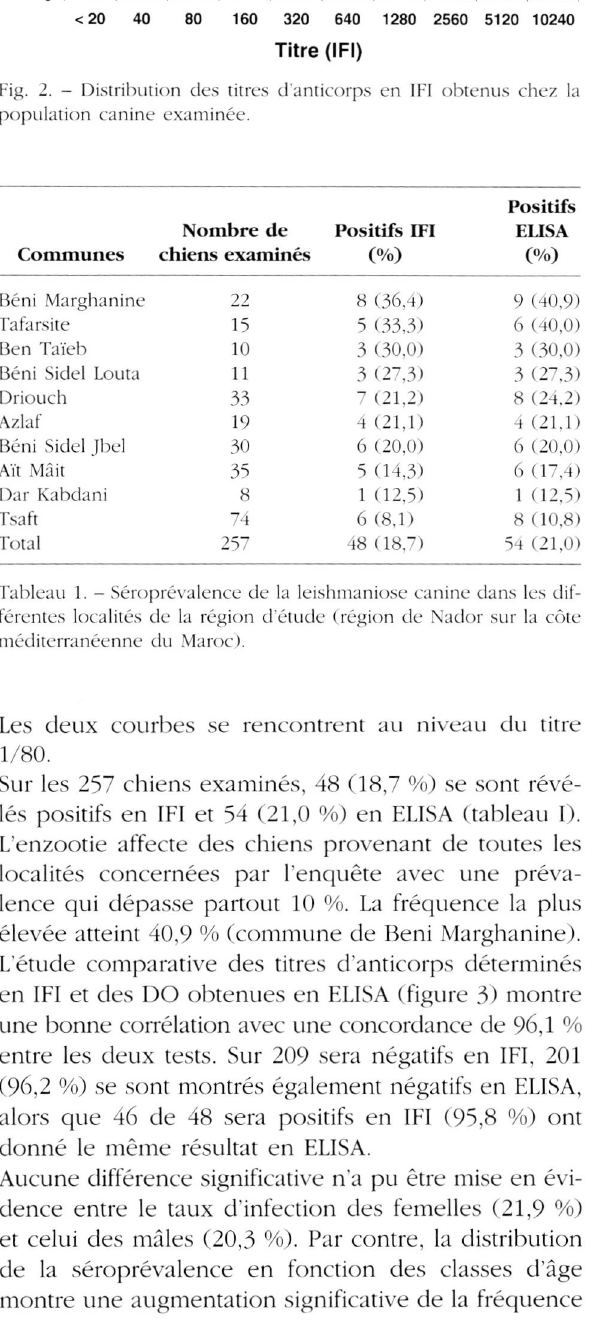
Fig. 2. - Distribution des titres d'anticorps en IFI obtenus chez la population canine examinée.